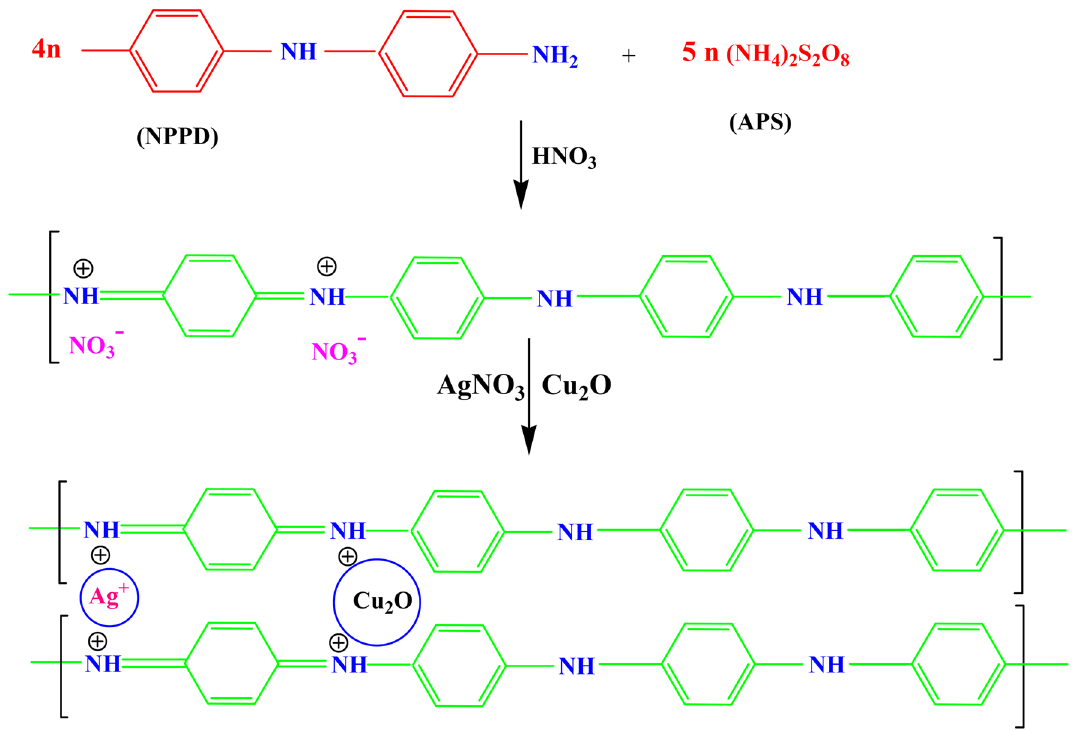
Figure 1. Formation mechanism of TANI/Cu 2 O/Ag